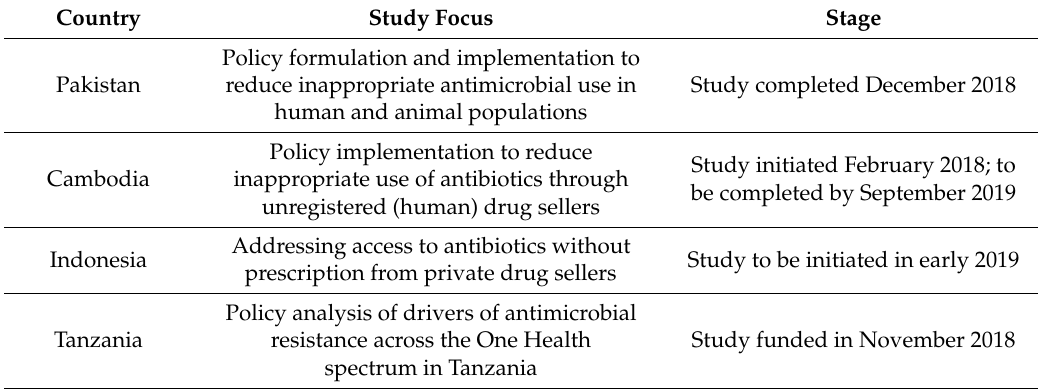
Table 1. Application of the new framework in diverse low- and middle-income country (LMIC) settings. Country Study Focus